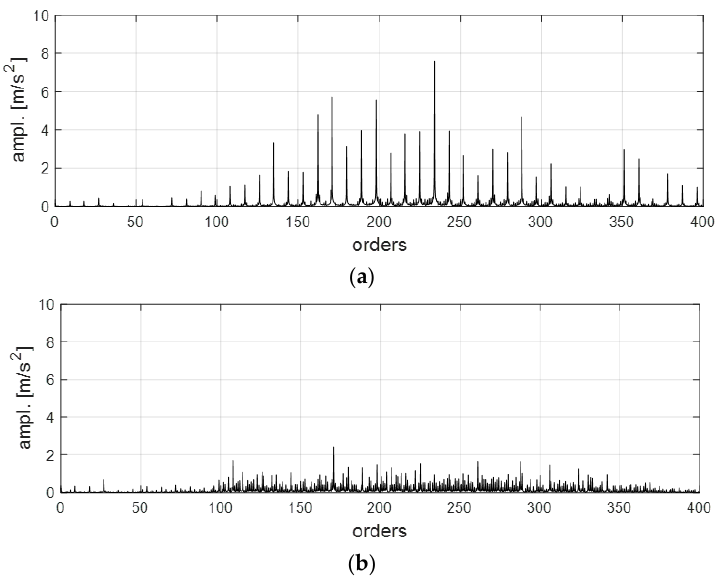
Figure 9. FFT of the synchronous average for ( a ) the flawless pump and ( b ) faulty pump for the signal acquired with sensor 1 (1500 r/min, 150 bar).